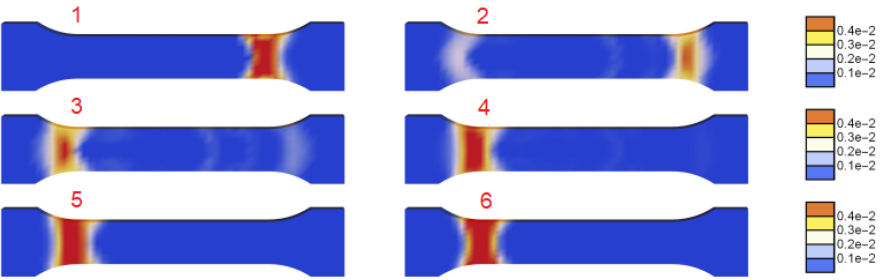
Figure 10. Distributions of ˙ γ at numbered states ( ξ = 40 MPa · s, k = 121 J/(s · K · m) and t 0 = 0.125